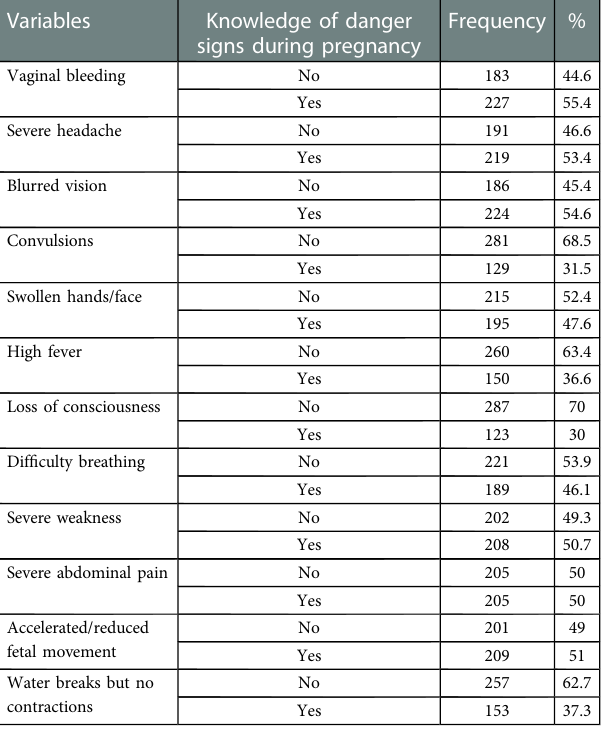
TABLE 3 Pregnant women ’ s knowledge of the key danger signs during pregnancy in Hosanna Zuria Kebeles, Hadiya Zone, southern Ethiopia, 2021 ( N =410).